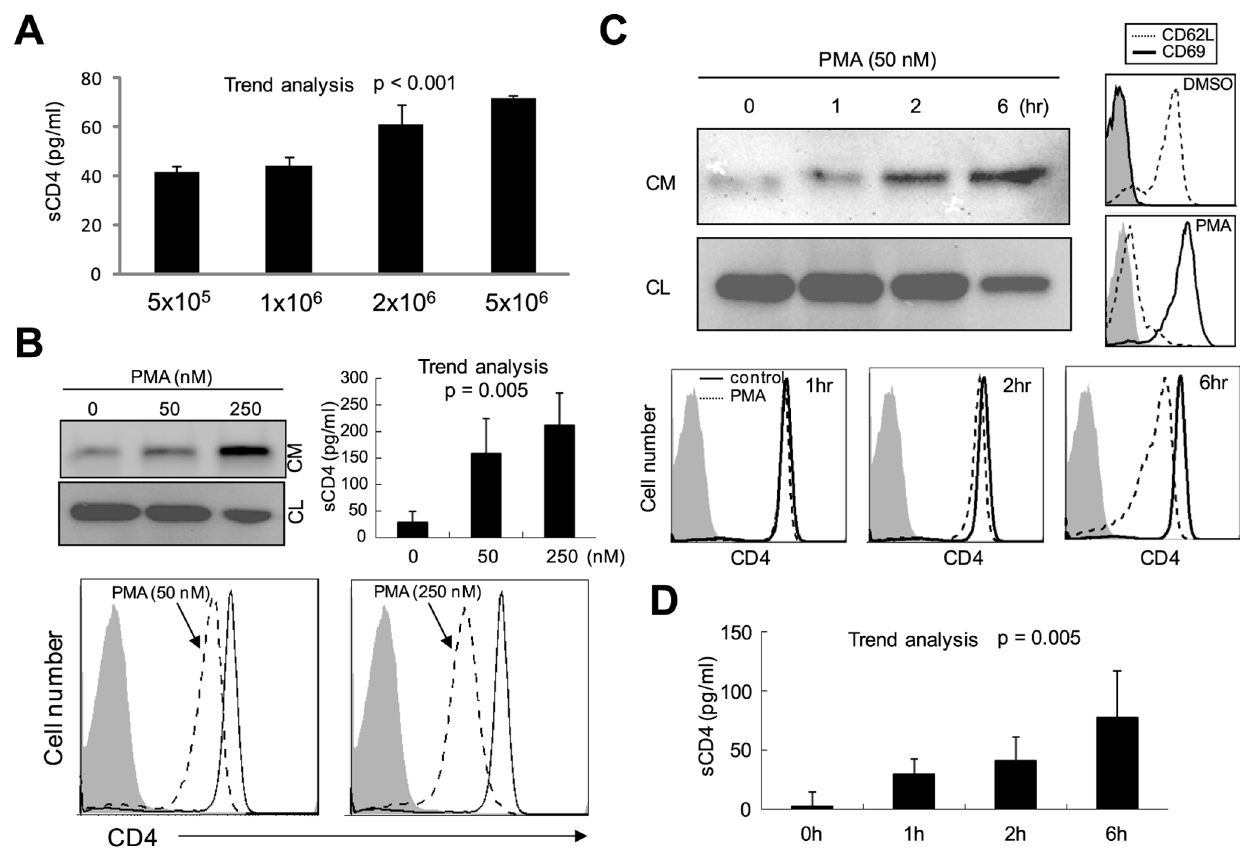
Figure 2. sCD4 is also generated in primary CD4 + T cells. (A) CD4 + T cells were purified from healthy volunteers and cultured in different cell densities as indicated. CM was then collected for ELISA analysis. (B-D) 1 6 10 6 CD4 + T cells were stimulated by PMA in different doses (B) for 3 hr or 50 nM PMA for different time periods (C and D) before collecting CM, CL and cells for ELISA, WB and FACS analysis. In addition, stimulated CD4 + T cells were stained with cell activation markers CD62L and CD69 and analyzed by FACS analysis (C). Statistical significance was assessed by the trend analysis.